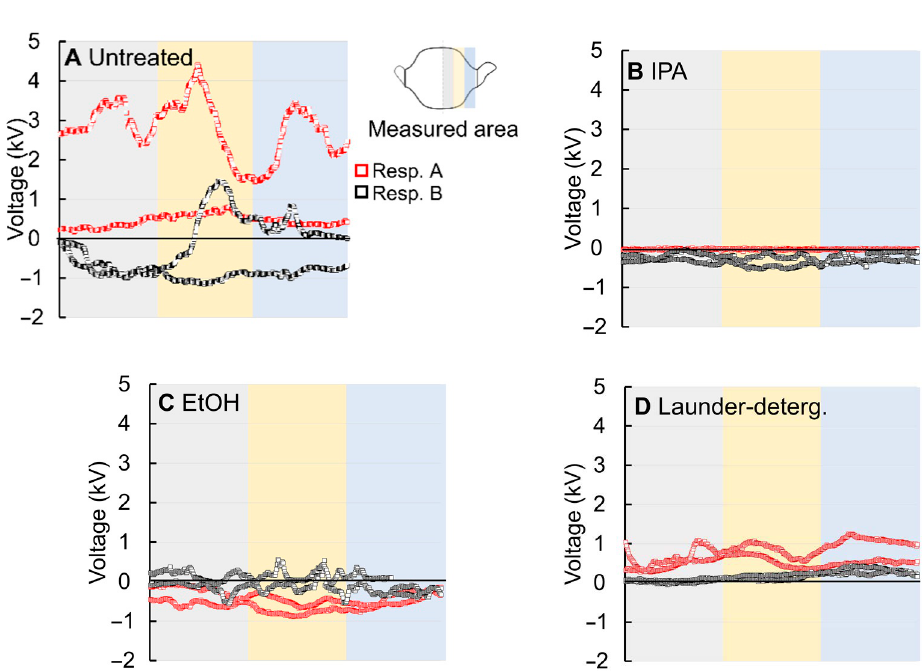
Figure 3. Surface potential of respirators with varied treatments, corresponding to ( A ) untreated, ( B ) IPA-immersed, ( C ) EtOH-immersed, and ( D ) laundered with detergent. The potential was measured by line-scanning in a horizontal direction across the shaded area.